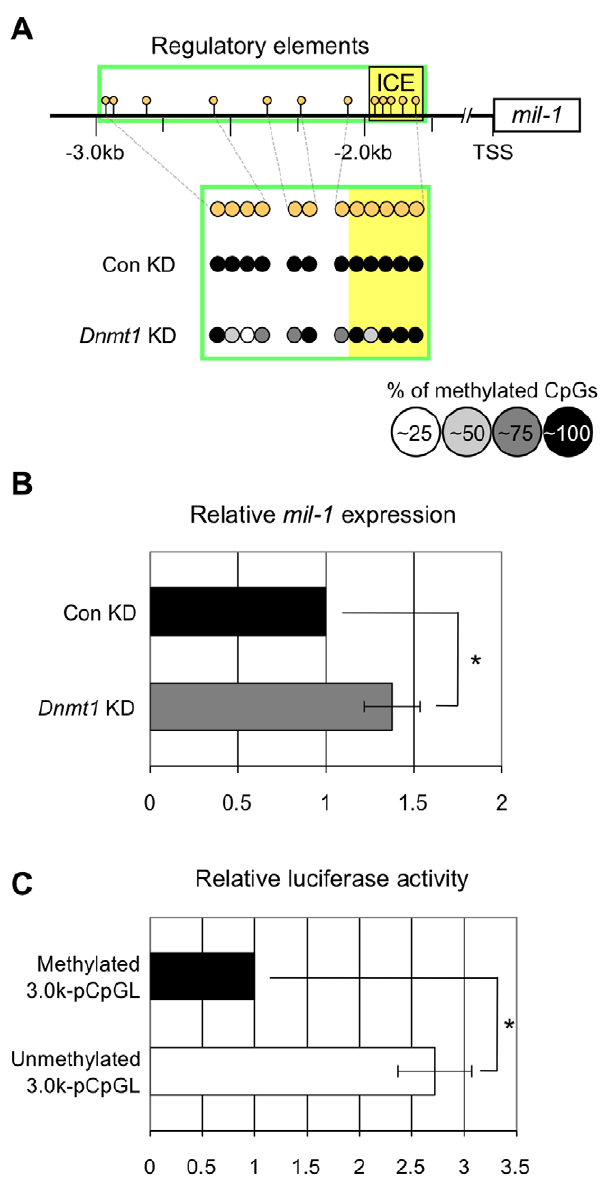
Figure 3. DNA demethylation of the regulatory region of mil-1 resulted in upregulation of its expression in ES cells. (A) Bisulfite sequencing analysis of the regulatory region of mil-1 and (B) quantitative RT-PCR analysis of mil-1 expression were performed on embryonic stem (ES) cells with or without siRNA-mediates Dnmt1 knockdown ( Dnmt1 KD/Con KD). (A) The regulatory region became more hypomethylated following Dnmt1 knockdown. (B) Histogram represents the relative expression level of mil-1 in the Dnmt1 - knockdown ES cells. The expression level in the control ES cells (Con KD) was set as 1.0. Gapdh PCR signal was used an internal control to measure relative expression. The data were obtained from four independent experiments. *p , 0.05. Error bars represent SEM. (C) Luciferase activity of the reporter vectors with methylated or unmethylated regulatory region of mil-1 in ES cells. Luciferase activity was normalized against the activity of a cotransfected Renilla construct. The liciferase activity of the methylated construct (Methylated 3.0k- pCpGL) was set as 1.0. The data were obtained from six independent experiments. *p , 0.05. Error bars represent